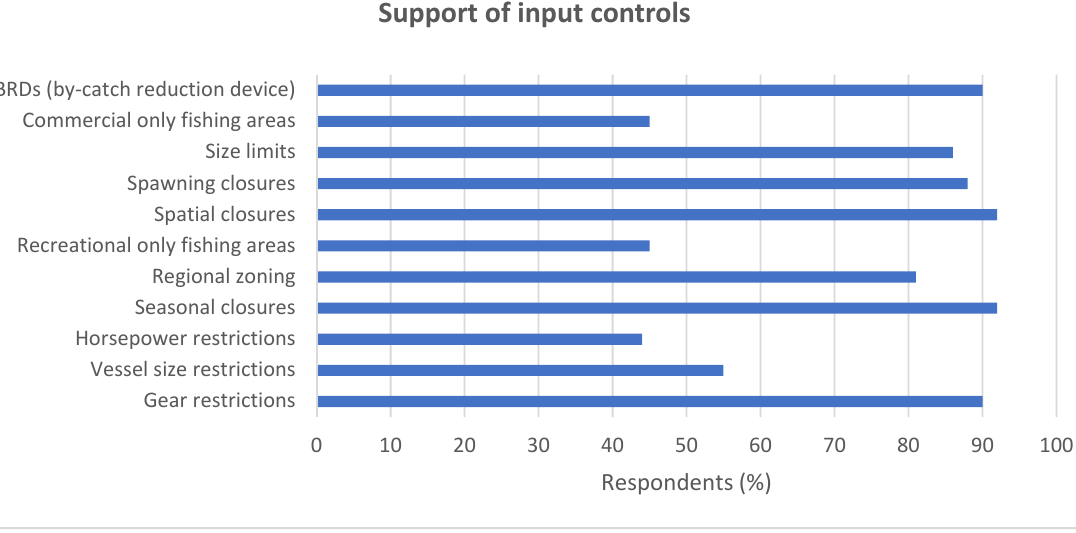
Figure 14. The level of support for several input controls shown by marine experts (n =